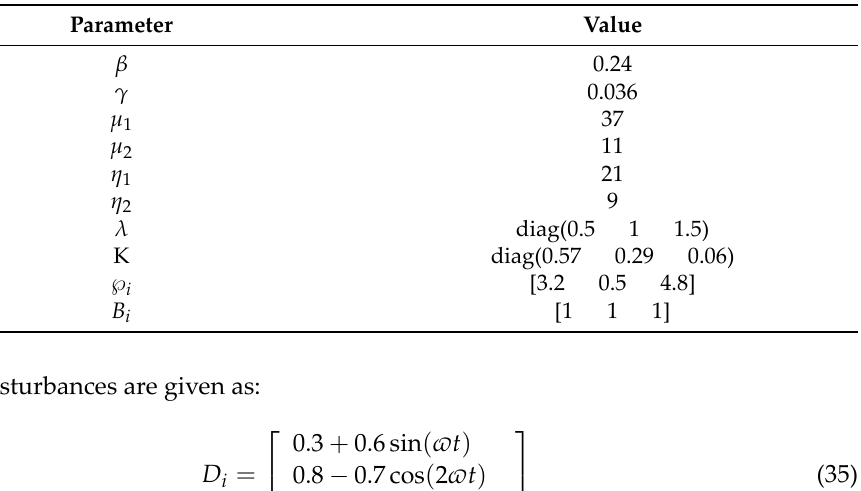
Table 2. The controller values.